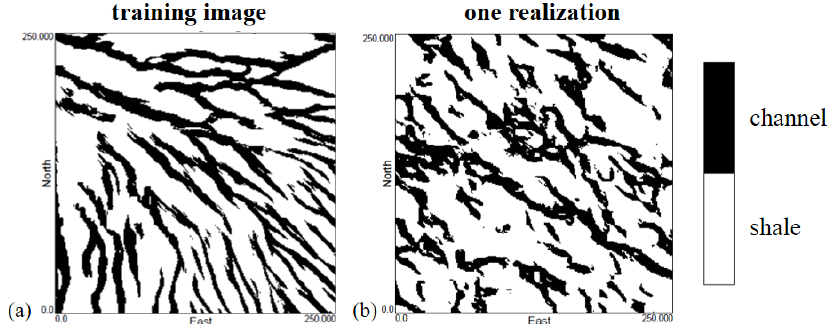
Figure 2. Multi-point geostatistics is hard to reproduce the non-stationary geological patterns (modify according to reference [11]). ( a ) The training image with non-stationary geological patterns; ( b ) one realization produced by multi-point